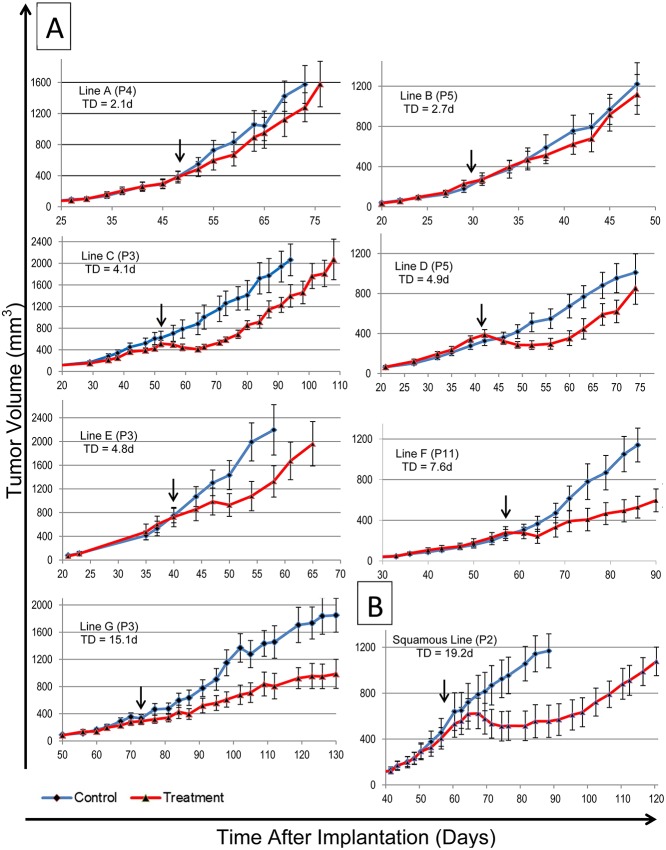
Chemosensitivity of primary E/GEJ cancer xenograft lines was tested with a combined dose of paclitaxel and cisplatin.Means ± SEM (n = 10 mice per group) were plotted. Arrows indicate the time at treatment. Lines are arranged in ascending order of their time delay at doubling volume (TD), measured in days (d). (A) Seven adenocarcinoma lines range in the degree of sensitivity to these agents. Lines A and B show clear signs of resistance while the remaining lines show various degrees of sensitivity. Line H was tested for chemotherapy but due to mouse toxicity could not be completed. Due to the slow growing nature of the tumor, Line I was not tested because not enough tissue could be propagated. (B) The squamous cell carcinoma line is very sensitive to the treatment and is presented here for comparison purposes. Note: The data for Line B (P5) and Line F (P11) has previously been published and corresponds to Line 8 (P5) and Line 1 (P11) in Dodbiba et al. Lab. Invest. 93, 397–407 (2013).